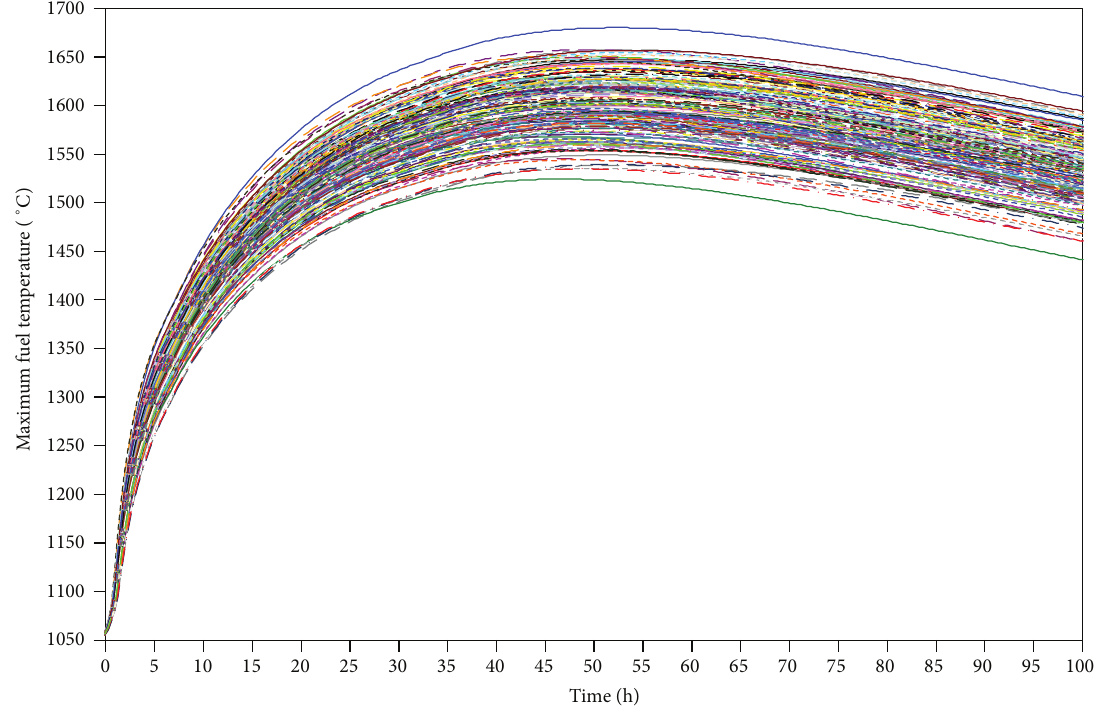
F 7: DLOFC maximum fuel temperature versus time for all 200 cases of the 200 LHS Normal set.